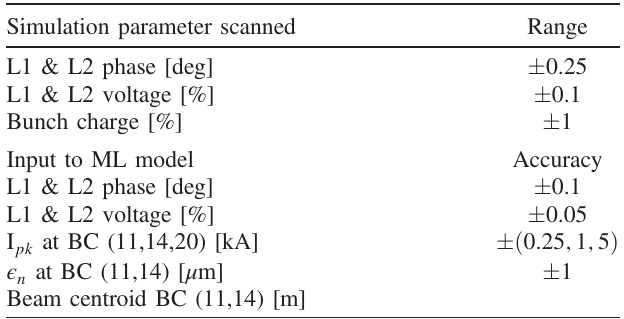
TABLE I. Linac and e-beam parameters scanned in the 5 5 simulations of the FACET-II accelerator. The ranges are chosen closely based on the jitter parameters from the FACET-II technical design report (TDR) [1]. The diagnostics fed to the ML model include random errors introduced artificially to approximate the measurement accuracy present in the accelerator.